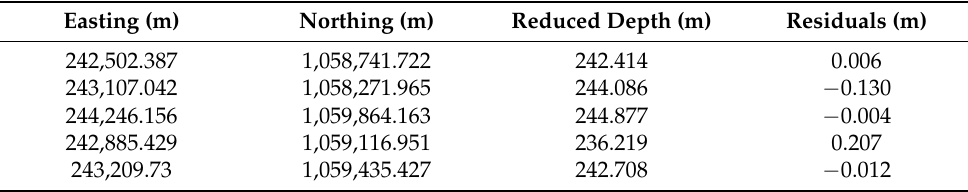
Table 3. Interactive